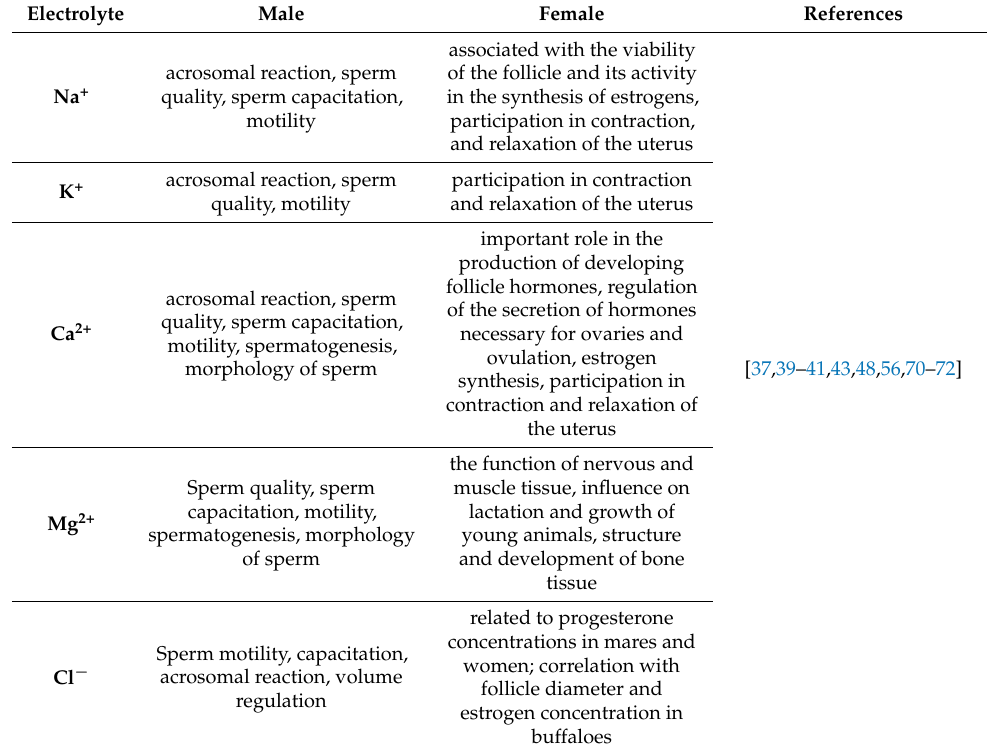
Table 5. The role of selected electrolytes in the male and female reproductive systems.